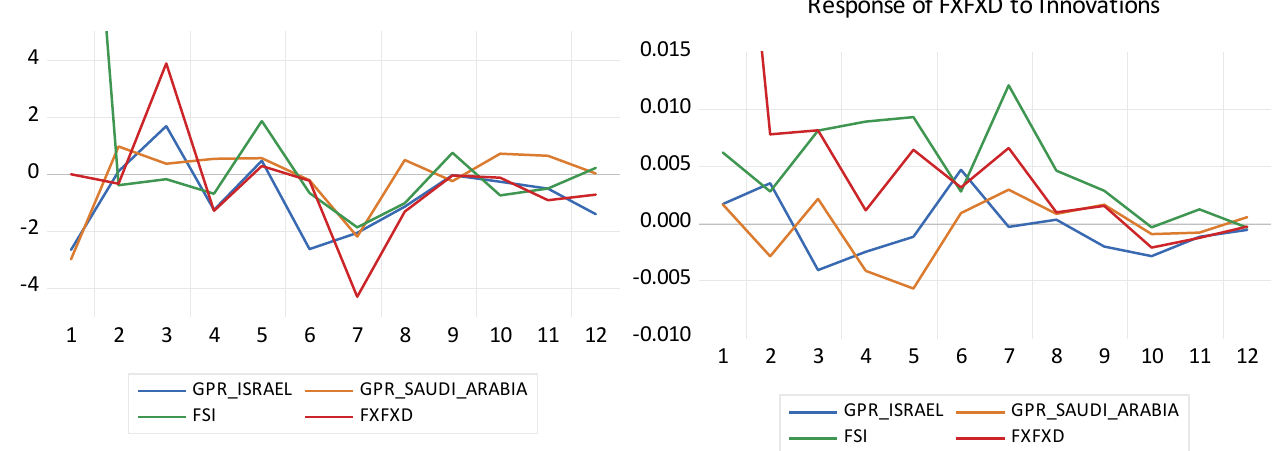
Figure 4. Combine impulse response functions of FSI and FXFXD to innovation.